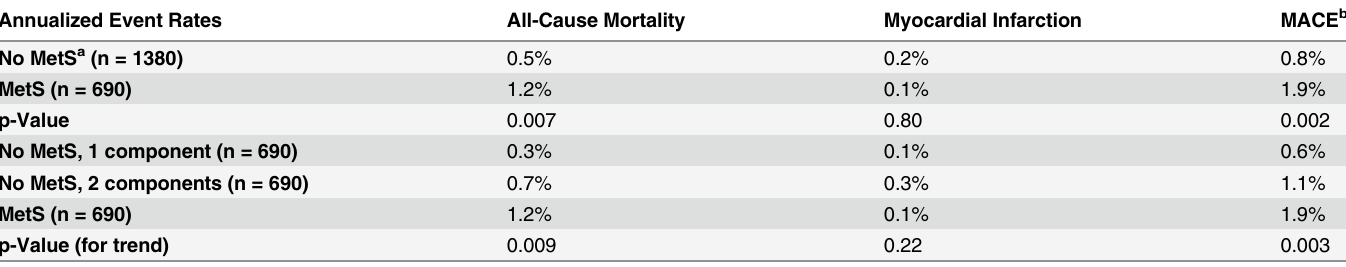
Table 3. Incident MACE rates for matched patients with versus without MetS.